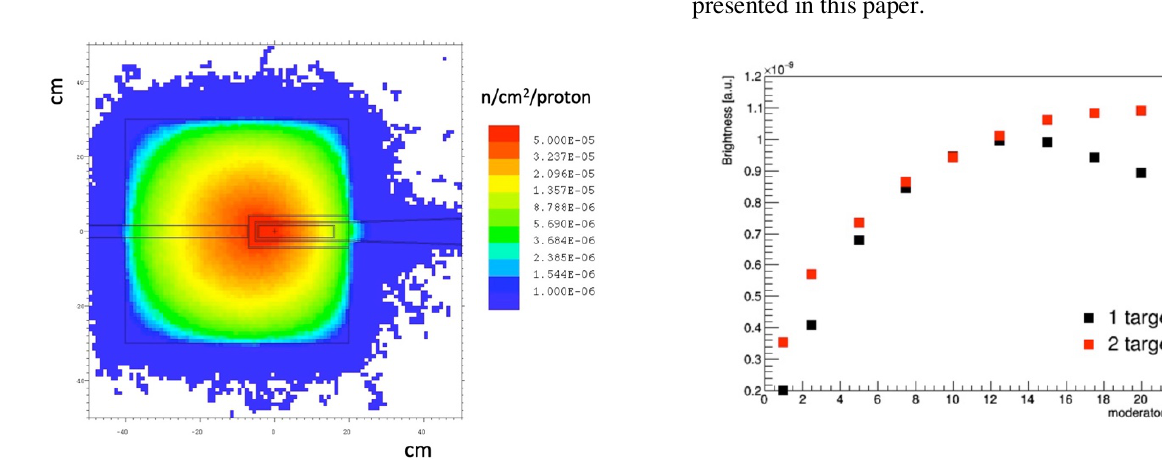
Fig. 5. Effect of moderator length on the source cold brightness (integral brightness below 5 meV) for the 1-target and 2-target